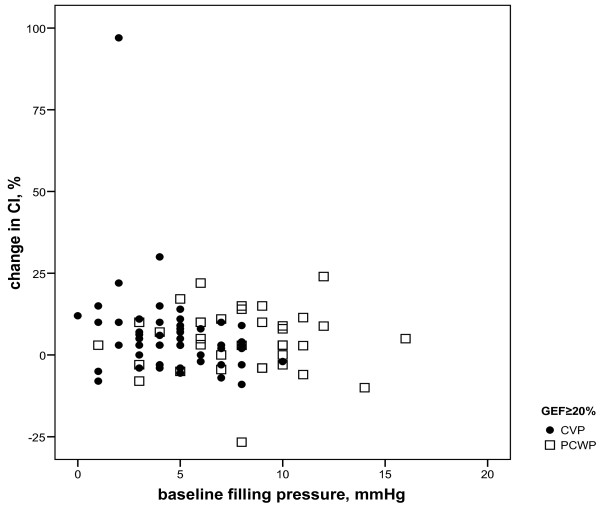
filling pressures (PAOP, CVP) versus change in cardiac index (CI) when global ejection fraction (GEF) is near-normal (≥20%): r = -0.01, P = 0.951 and r = -0.35, P = 0.009, respectively Baseline. For difference between r: P = 0.023.